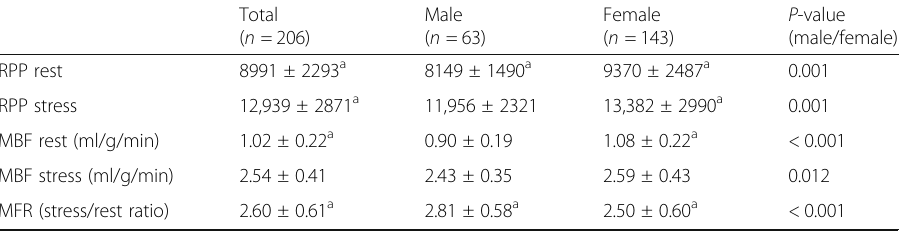
Table 2 Mean Rate Pressure Product, Myocardial Blood Flow and Myocardial Flow Reserve with residual activity correction divided by sex Total ( n = 206)